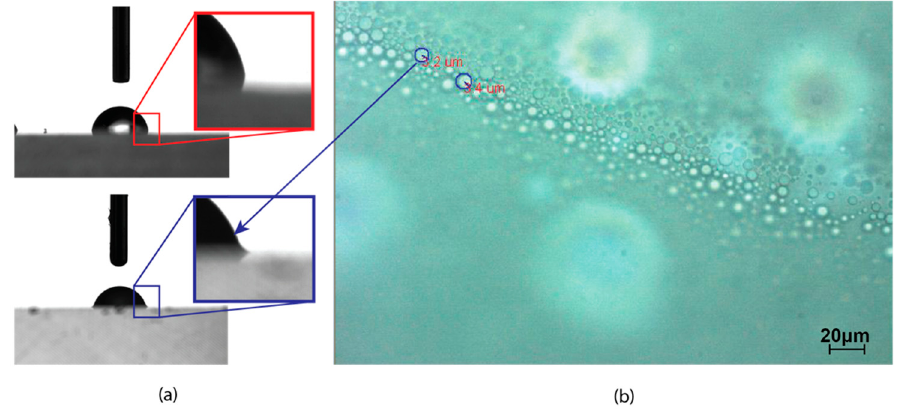
Figure 1. Captured images of droplets. ( a ) Contact angles of water (upper) and nanodroplet cutting fluid (NDCF) (lower); ( b ) optical micrograph of nanodroplets.